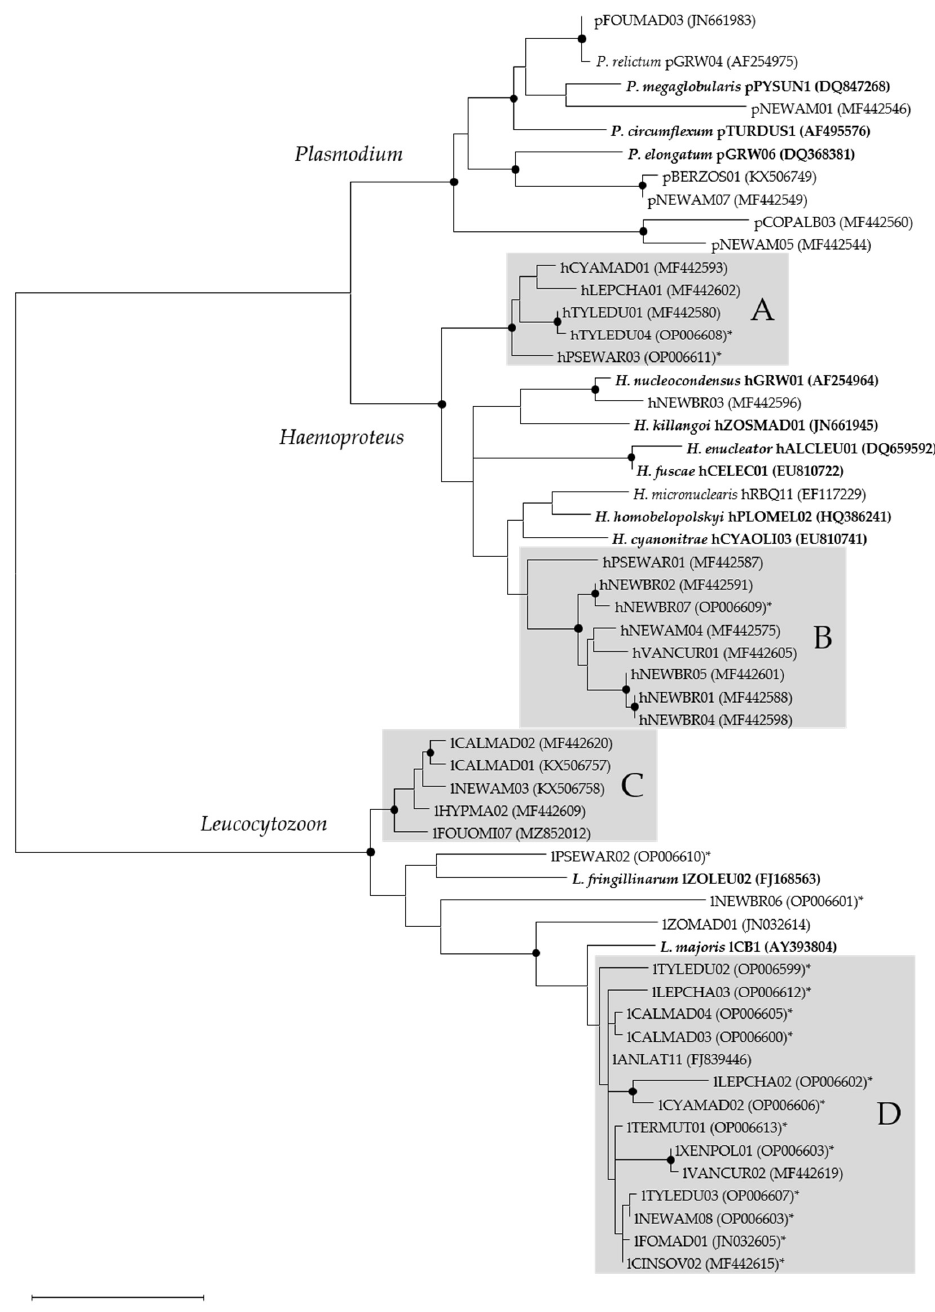
Figure 3. Phylogenetic relationship of 56 mitochondrial cytb lineages of haemosporidian parasites detected in blood samples of birds belonging to the superfamily Corvoidea on Madagascar, along with sequences of different morphospecies, constructed using maximum likelihood (GTR + G). Dots on nodes indicate bootstrap values >70%. In brackets are given GenBank accession numbers for all lineages. Morphospecies are written where linked to the characteristic lineages. Those in bold were not detected throughout this study. New lineages that were found for the first time in the present study are marked with an asterisk (*). Grey boxes ( A – D ) indicate groups of closely related cytb lineages.